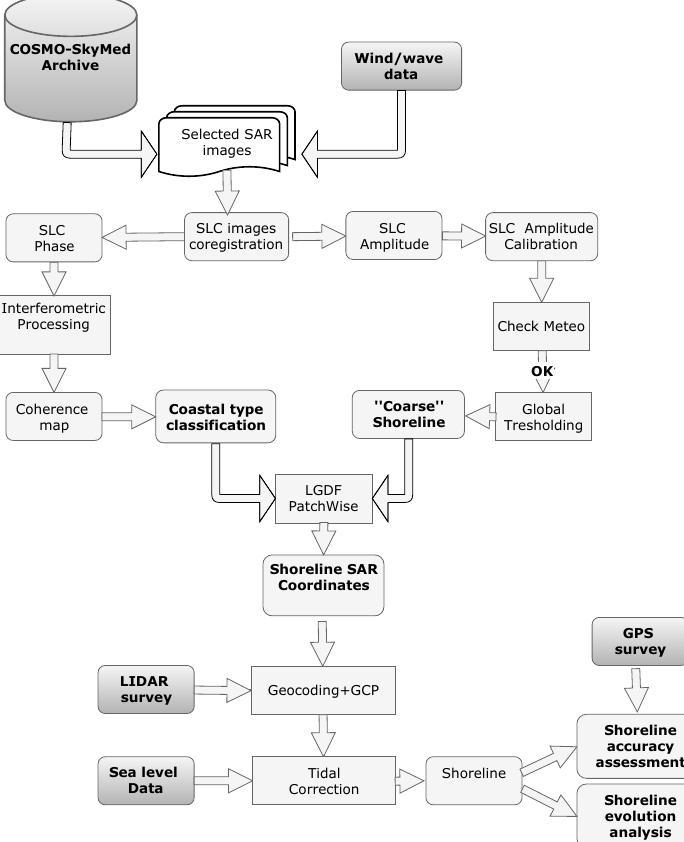
Figure 1. Diagram flow of the COSMO-Beach coastal monitoring